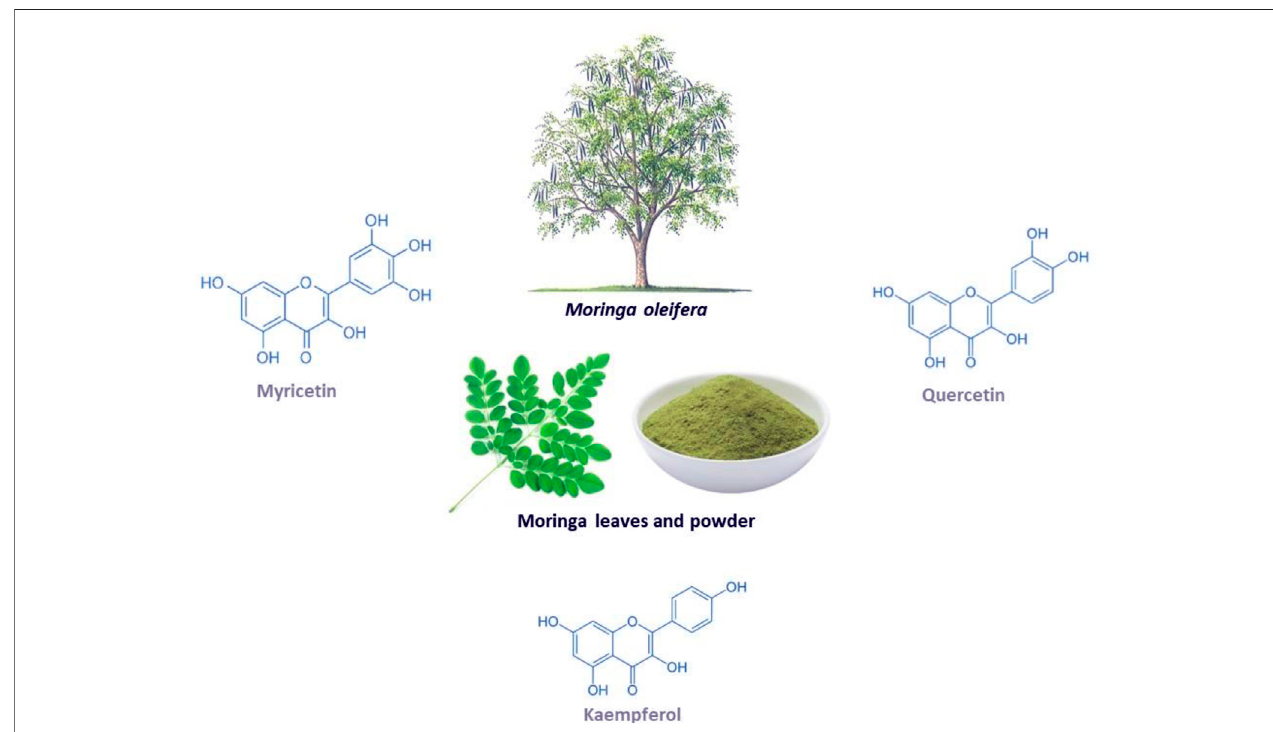
FIGURE 1 | The Moringa oleifera plant, including the chemical structures of some of its major fl avonoids myricetin, quercetin and kaempferol.